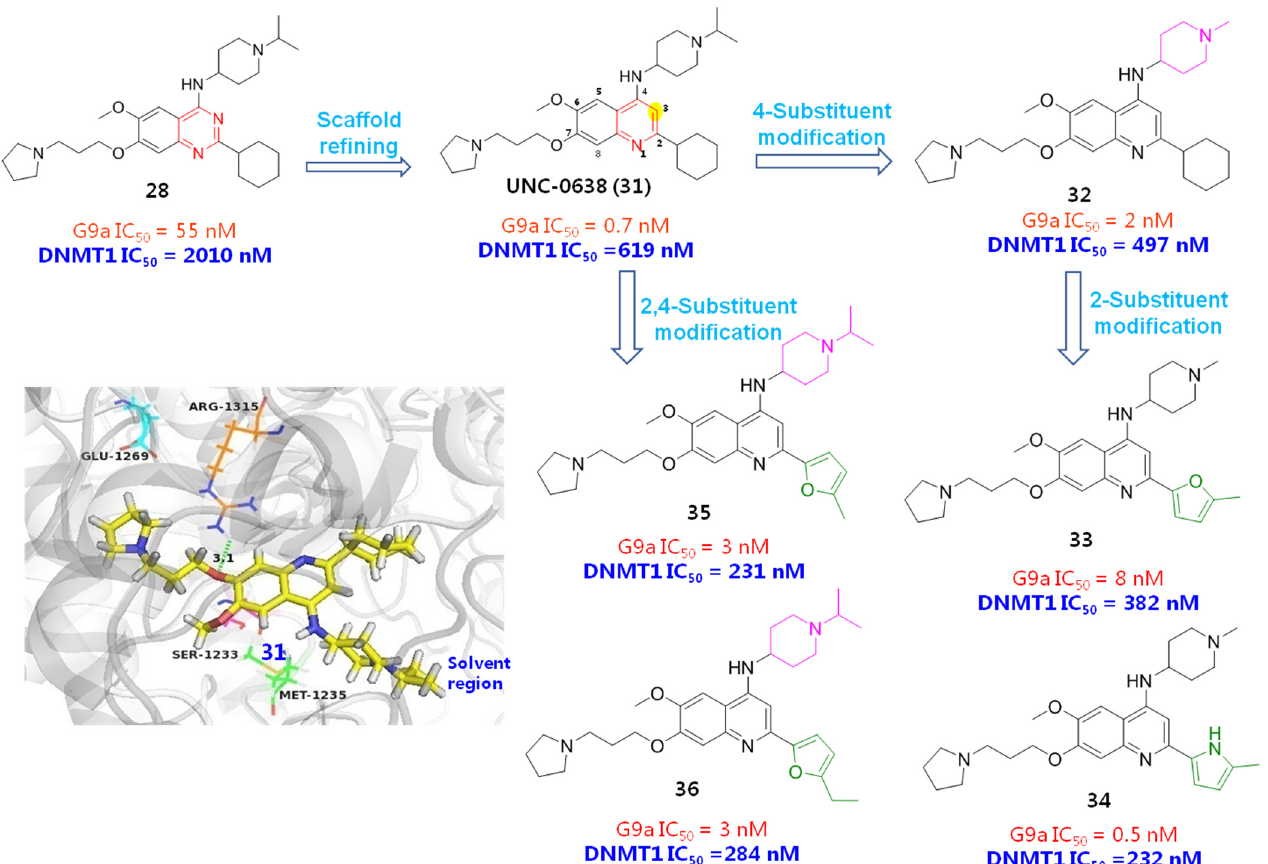
Figure 9. Structural optimizations based on G9a/DNMT1 dual inhibitor (28) by refining the quinazoline scaffold and substituents at 2- and 4-positions led to quinoline-based derivatives 31~36 with more potent G9a/DNMT1 inhibitory activities; binding pattern of 31 with mouse DNMT1 was also displayed to guide further optimizations.